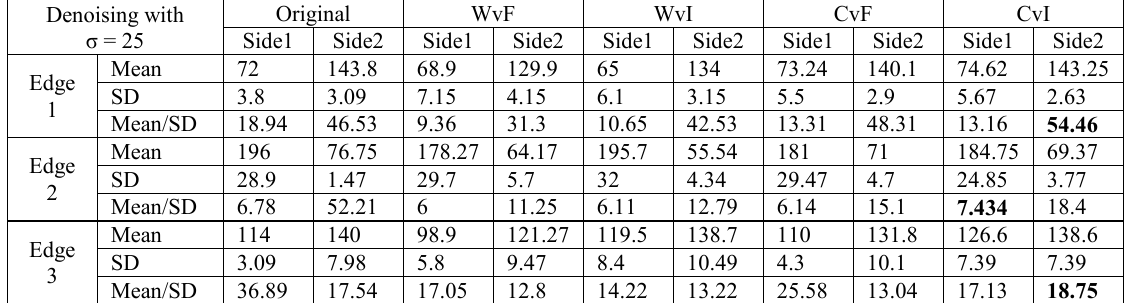
Table 6: Edge preservation capability for Landsat TM image (σ =